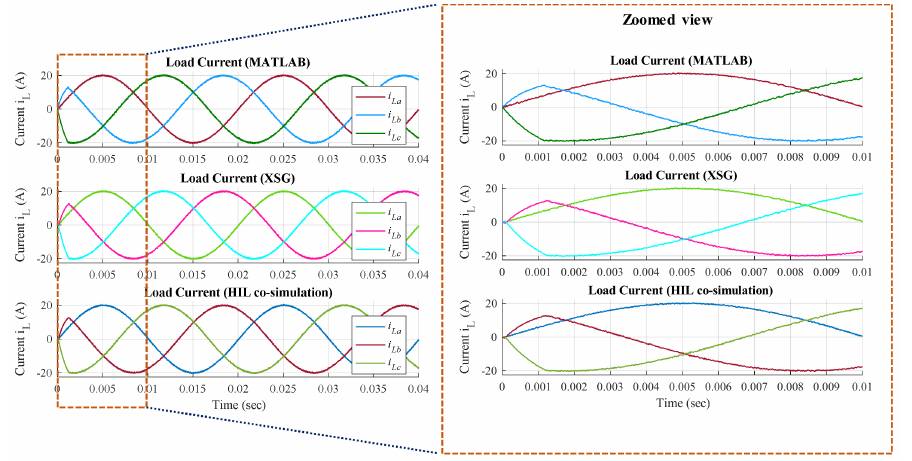
Figure 15. Three-phase load currents obtained using MATLAB/Simulink, XSG, and HIL co-simulation for T S = 20 µ